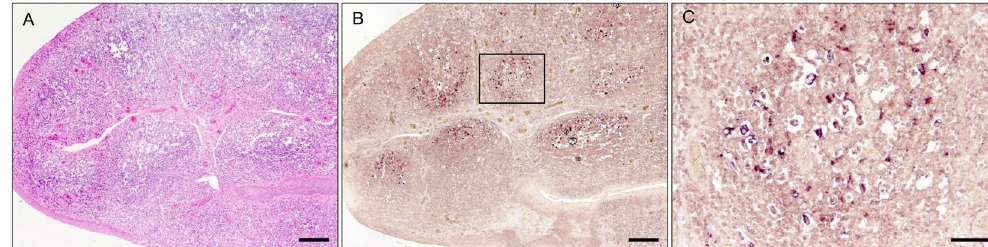
Figure 1. Histology of hyperplasia tonsillitis ( A ) and in situ hybridization ( B , C ) of CanineCV specific probe of dog no 14P105D TH/2016 showing strong positive signals in lymphoid follicles of the tonsil ( B ), located in the cytoplasm of lymphoid cells ( C ). The lymphoid follicle shown at higher magnification in ( C ) is indicated by a box in ( B ). Bar: A,B = 200 µ m; C = 50 µ